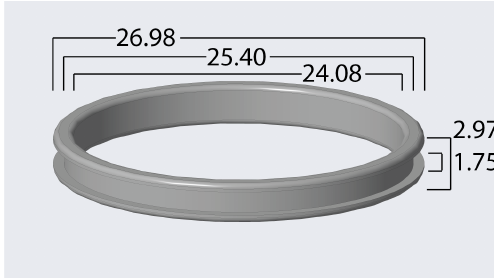
Figure 5. Schematic of a bobbin compatible with the S1000 geom- etry (mm).